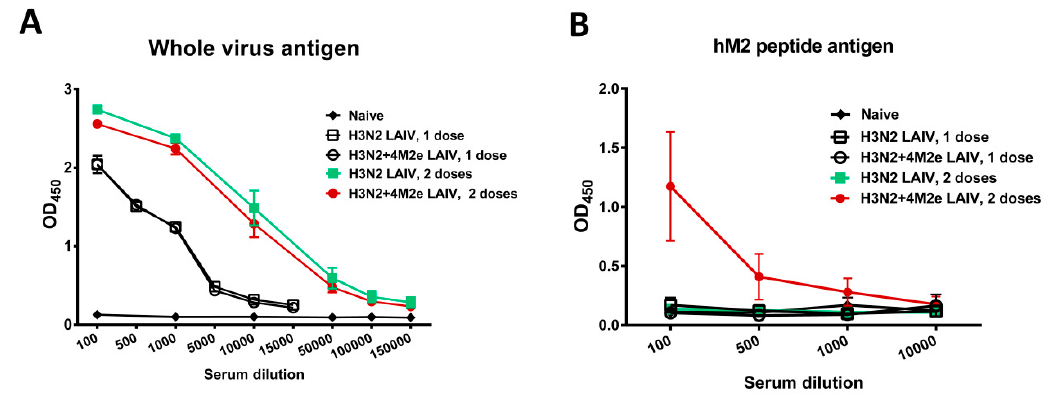
Figure 3. Serum IgG antibody responses to whole influenza virus antigen ( A ) and to human M2e peptide ( B ).